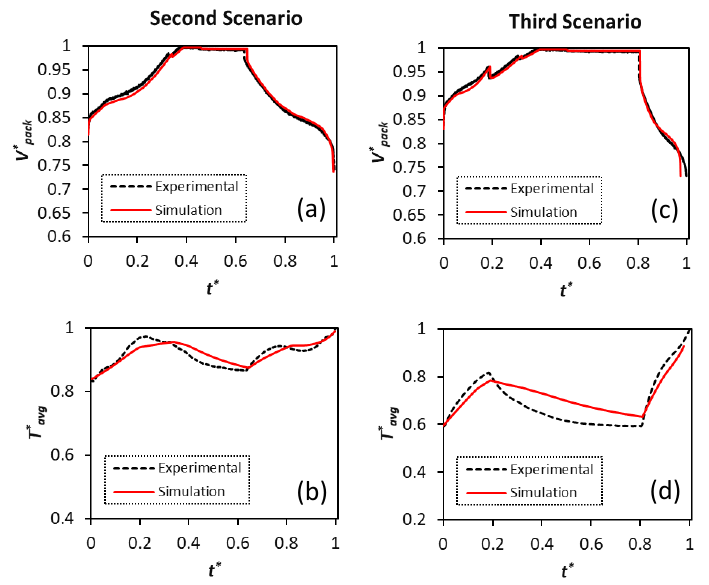
Figure 10. Lumped battery pack model evaluation. ( a , b ): second scenario (C/2 + C/3 CC charge, CV charge, rest, C/2 discharge); ( c , d ): third scenario (1.1 C + C/2 + C/3 CC charge, CV charge, rest, 1.5 C discharge).